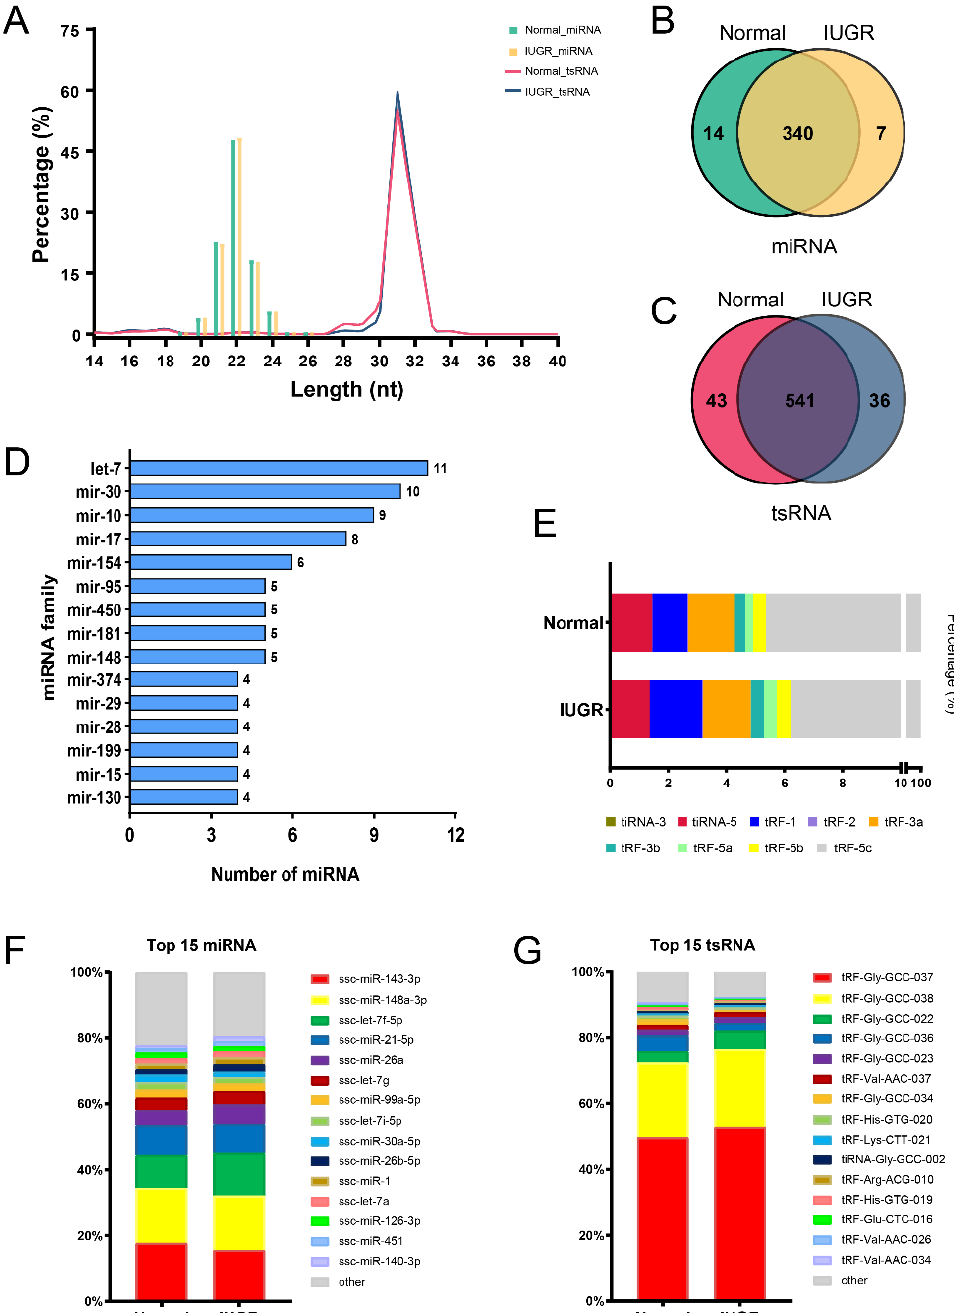
Figure 2. Sequence characteristics of miRNA and tsRNA profiling of pig spleen. ( A ) Length distribution of miRNA and tsRNA sequences. Venn diagram of the number of identified miRNAs ( B ) and tsRNAs ( C ). ( D ) The miRNA families of the identified miRNAs. ( E ) The types and distribution of identified tsRNAs. Composition of top 15 highly expressed miRNAs ( F ) and tsRNAs ( G ) in pig spleen.